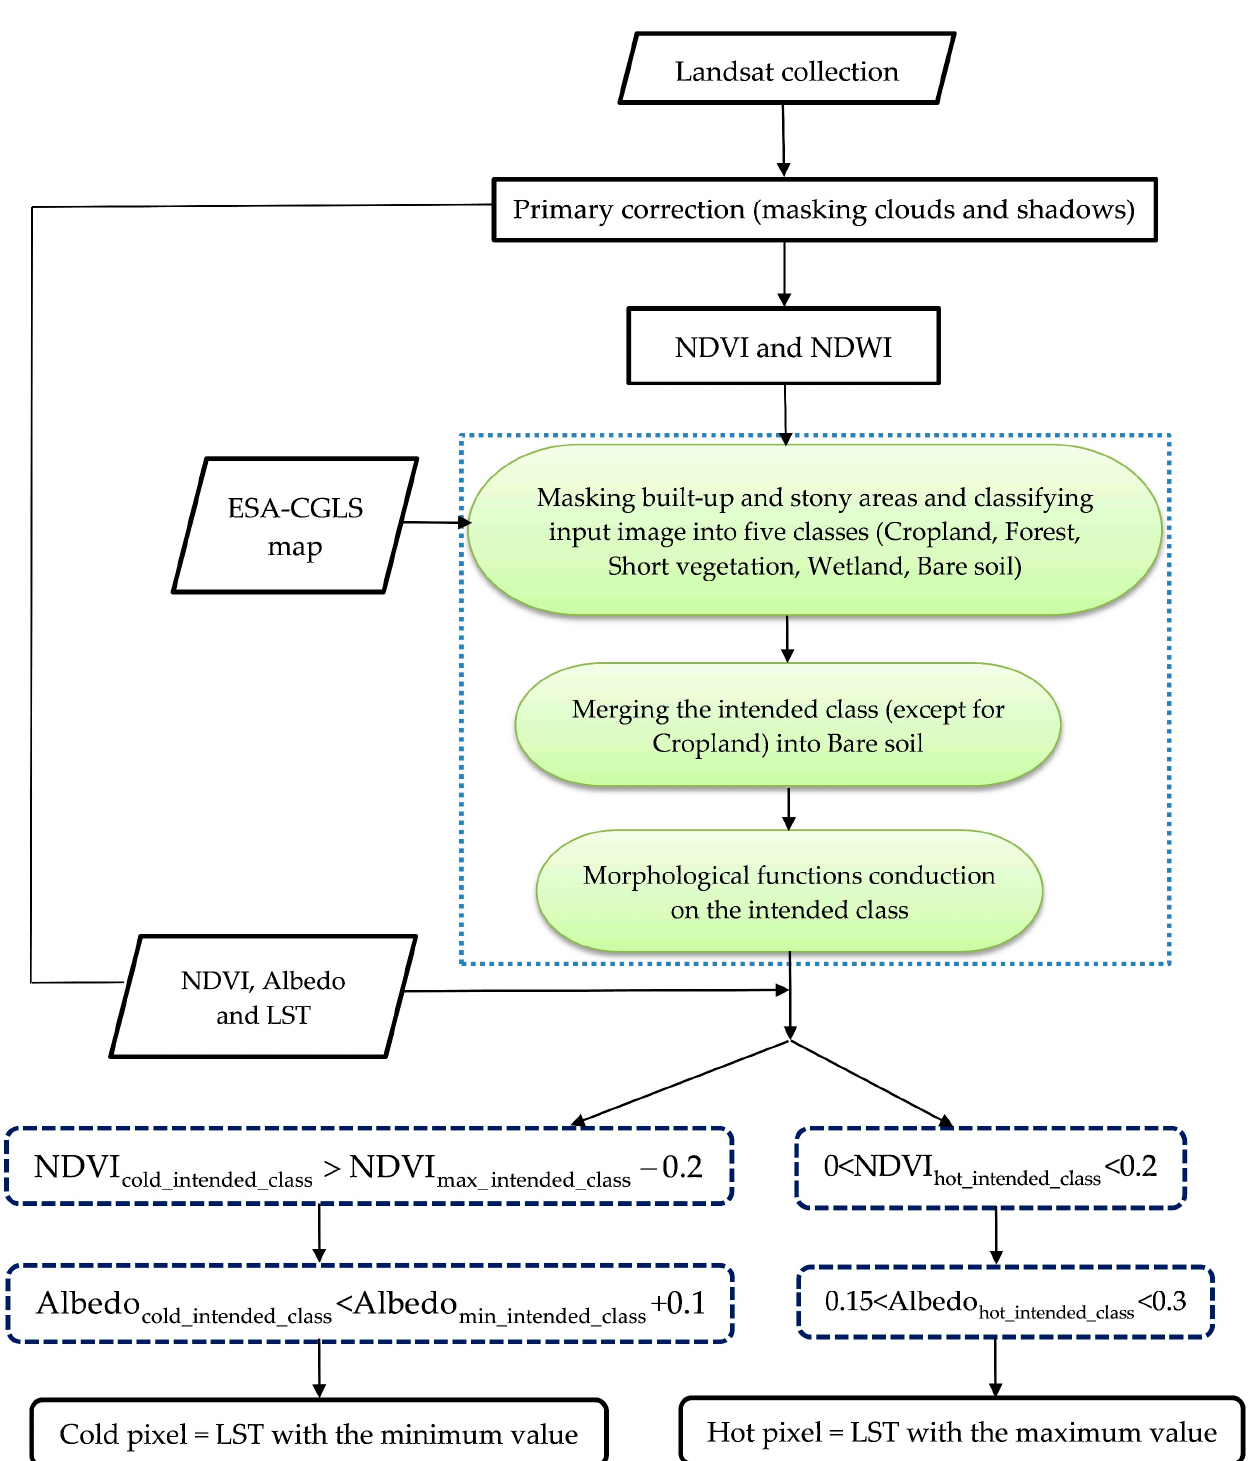
Figure 2. Endmember selection flowchart following the WF